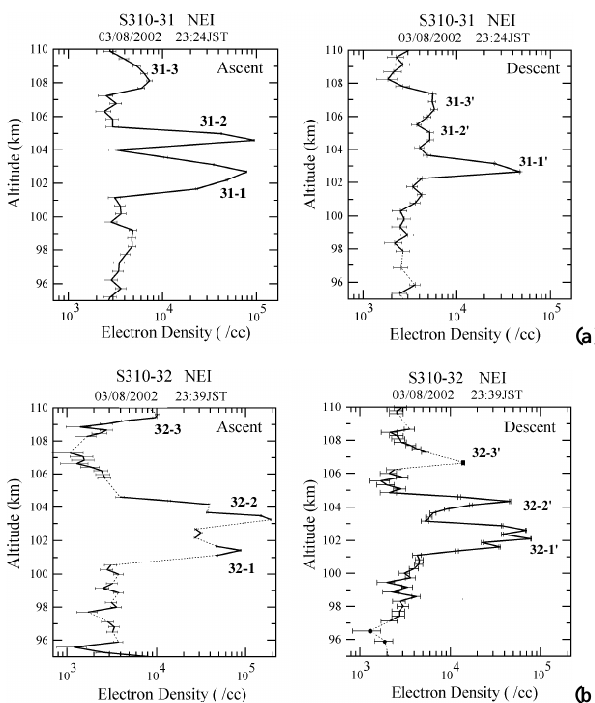
Fig. 1. (a) Altitude profiles of electron number density obtained us- ing the NEI instrument on board the S310-31 rocket (these panels represent the altitude range from 95 to 110km of Fig. 4a in Wak- abayashi et al. (2005)). There are sharp peaks due to E s layers at the altitude of about 102.7 and 104.6 km during the ascending phase (peaks are numbered as 31-1 and 31-2). There is only one sharp peak during the descending phase at the altitude of 102.6km (this peak is indicated as 31-1 0 ). (b) Altitude profiles of electron num- ber density obtained using the NEI instrument on board the S310- 32 rocket. Several dashed lines indicate the data blanks due to the TMA release. There are three enhancements of density at altitudes of 101.4, 103.2 and 109.6km during the ascent (they are numbered as 32-1, 32-2 and 32-3, respectively). The peaks during the descent are also numbered as well as during the